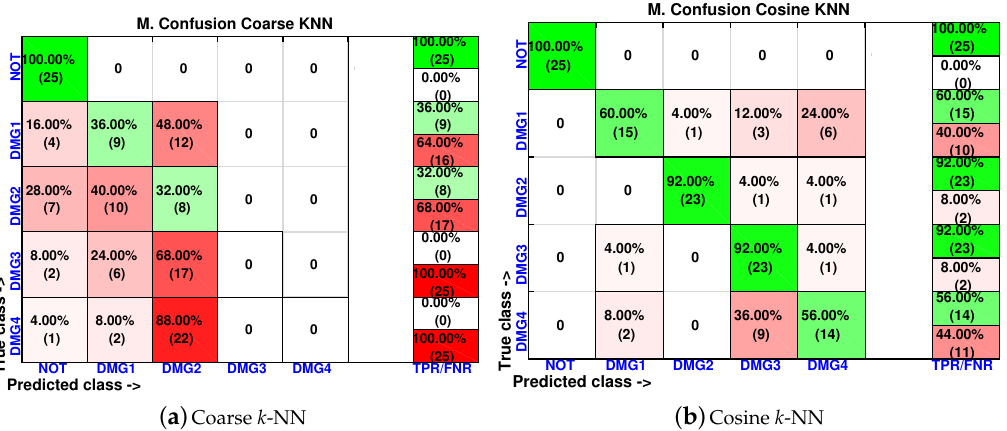
Figure 16. Confusion matrix using coarse k -NN and cosine k -NN when the feature vector is formed by the first principal